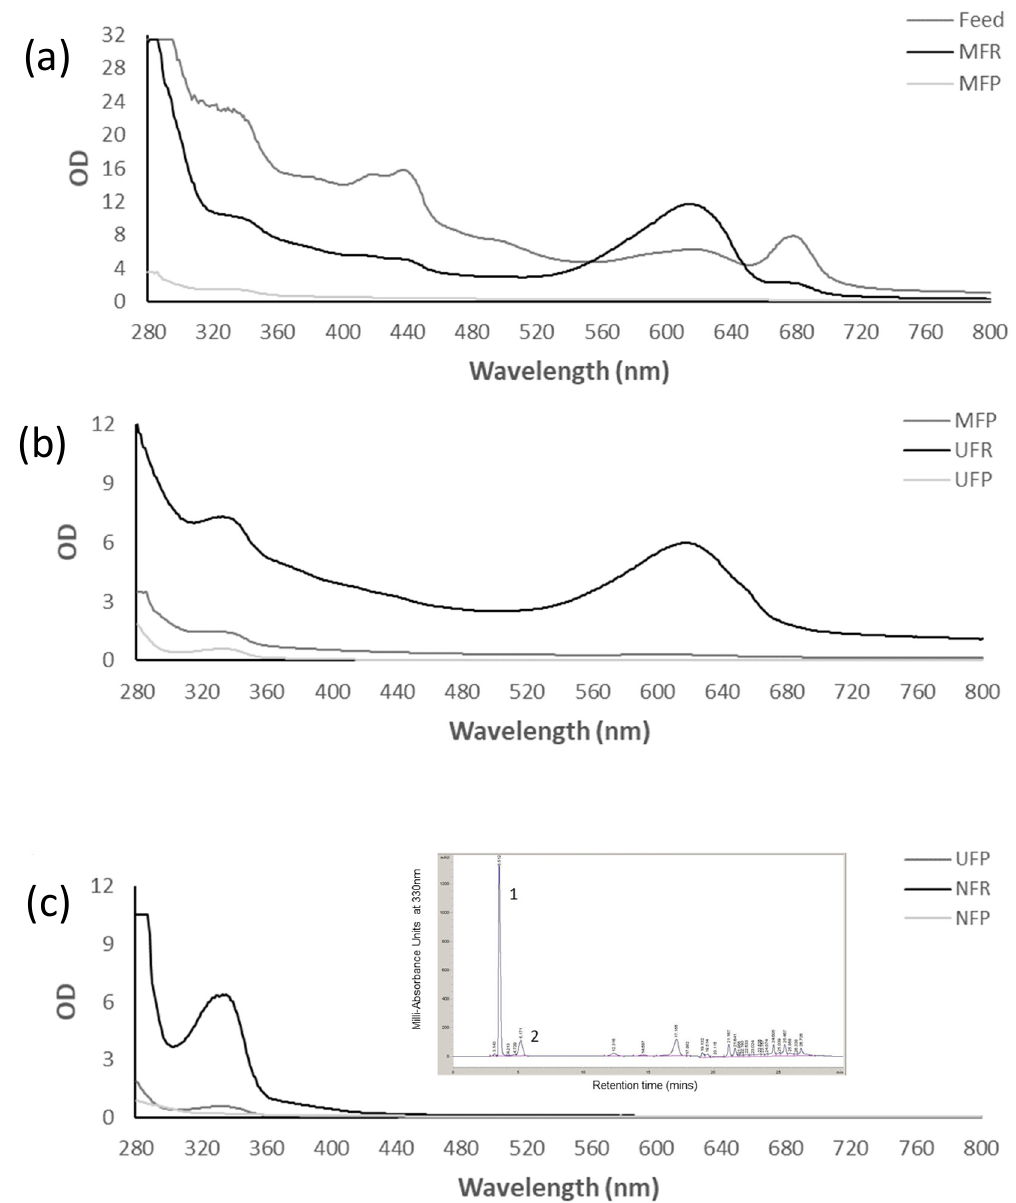
Figure 4. Absorption spectra of MF ( a ), UF ( b ) and NF ( c ) fractions with inset showing the correspond- ing NFR HPLC chromatogram with peaks 1 and 2 identified as shinorine and mycosporine-glycine, respectively. OD numbers are adjusted to reflect dilutions.